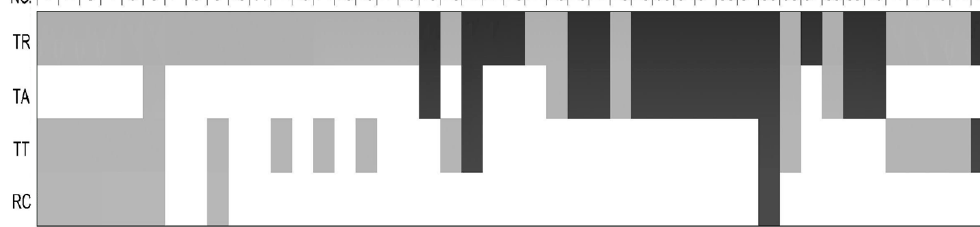
Figure 6. The major constituents of each extract were identified and collectively shown using mass spectrometric data analysis results in Table 2. Colour code: White, not involved; Black, anthraquinones; Gray, non-anthraquinones.